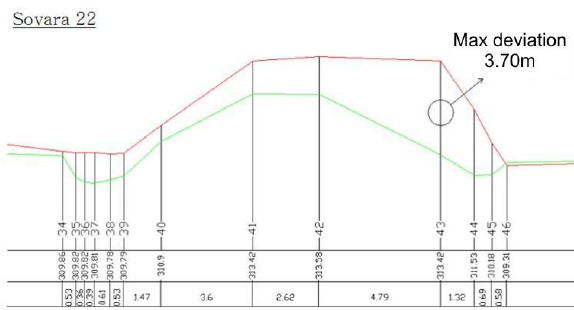
Figure 11. Example of area for which DTMs overestimate elevation. Topographic survey in green, DTM interpolated surface in red